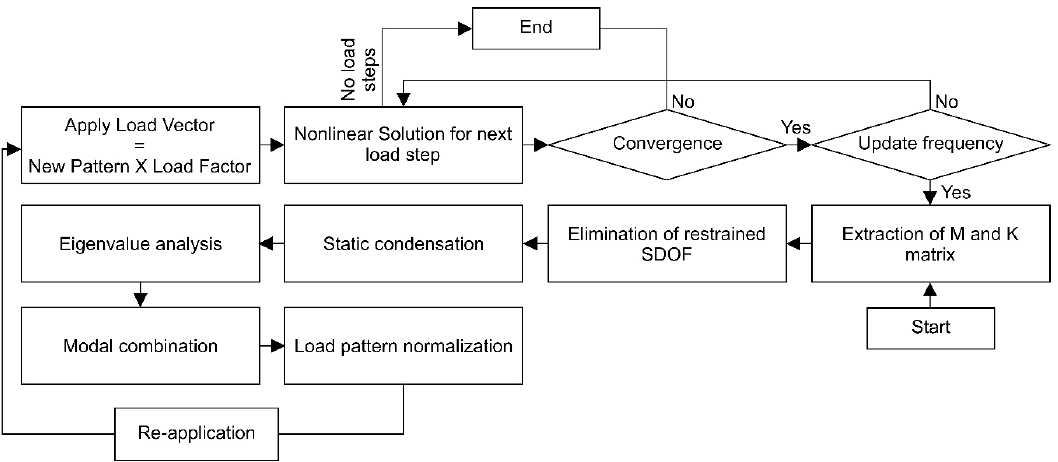
Figure 5. Flow chart of the adaptive pushover method (modified from [78]).